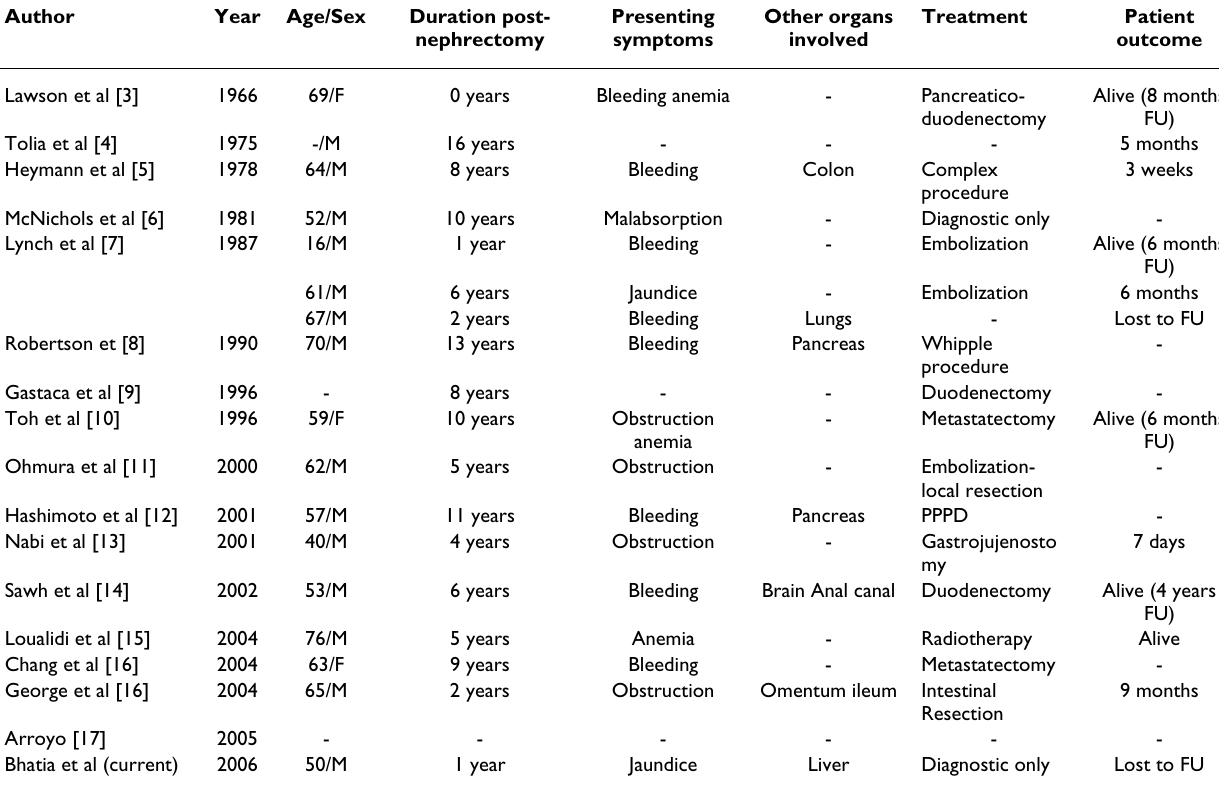
Table 1: Previously reported examples of duodenal metastasis in patients with renal cell carcinoma